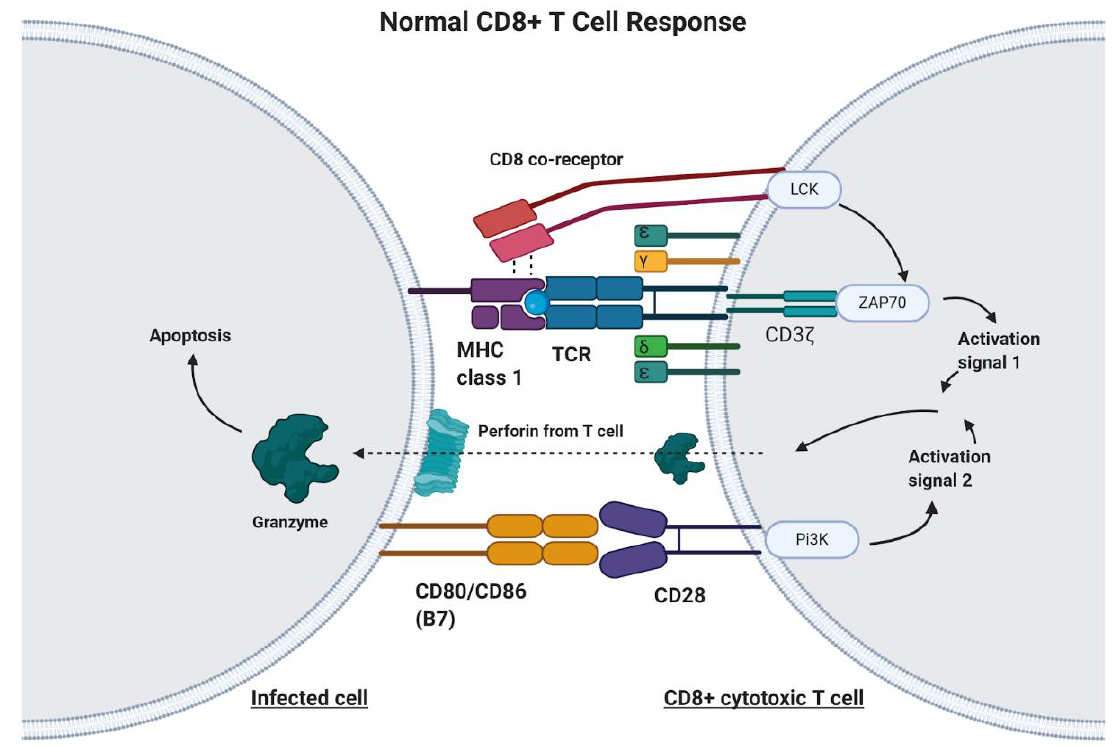
Figure 1. The Normal CD8+ T Cell Response. Infected cells will process and present a portion of the viral or bacterial protein on major histocompatibility complex (MHC) Class 1 molecules. The T cell receptor (TCR) on CD8+ T cells will recognize this antigen bound to MHC. The CD8 co-receptor helps with recognition of MHC Class I. Upon TCR/CD8 co-receptor binding, the intracellular CD8 and CD3 ζ domain work together to produce activation signal 1. Additionally, a costimulatory signal involving B7 and CD28 is required in order to promote T cell activation, cytokine production, and prevention of anergy and apoptosis. Upon cytotoxic T cell activation, the T cell releases perforin and granzyme, which act upon the infected cell to initiate the extrinsic apoptosis pathway.